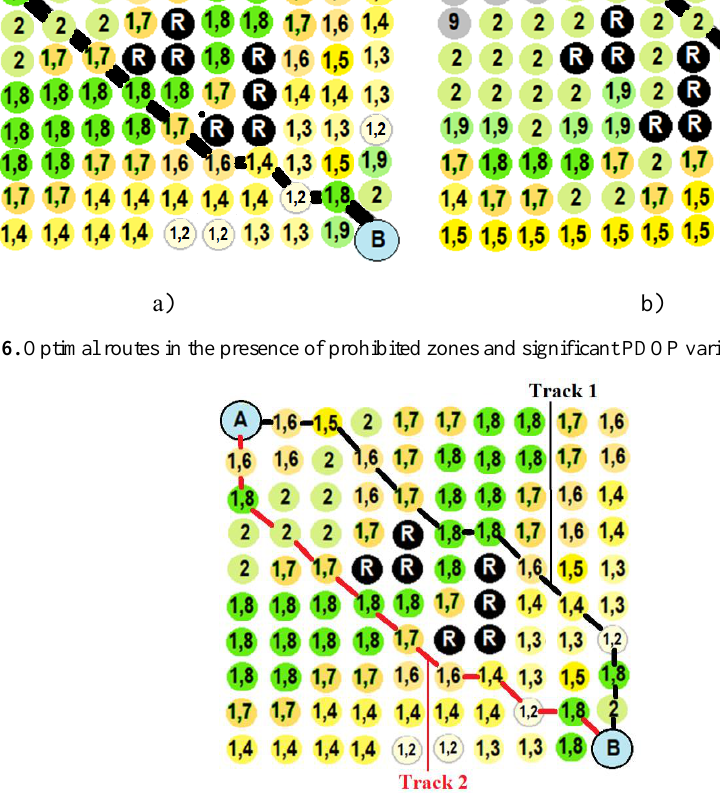
Fig. 7. Optimal and heuristic flight